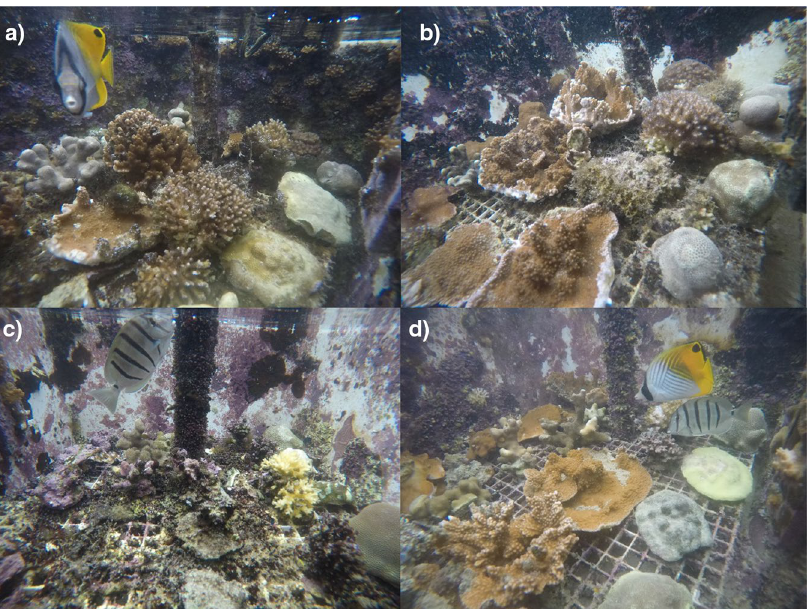
Figure 2. Representative photos of the mesocosms after twenty-two months of exposure to: ( a ) control, ( b ) ocean acidification, ( c ) ocean warming, and ( d ) future ocean treatment